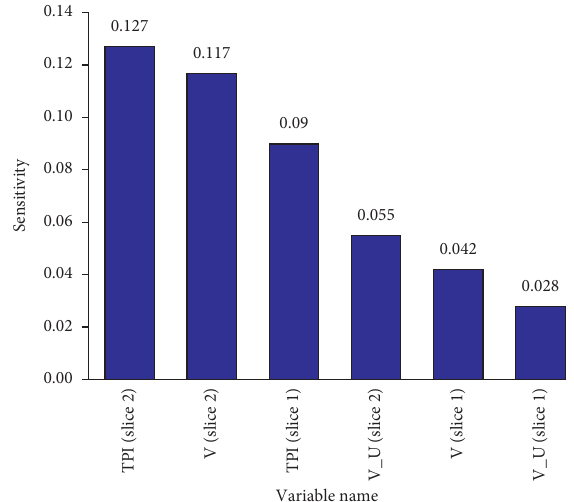
Figure 10: Results of sensitivity analysis.